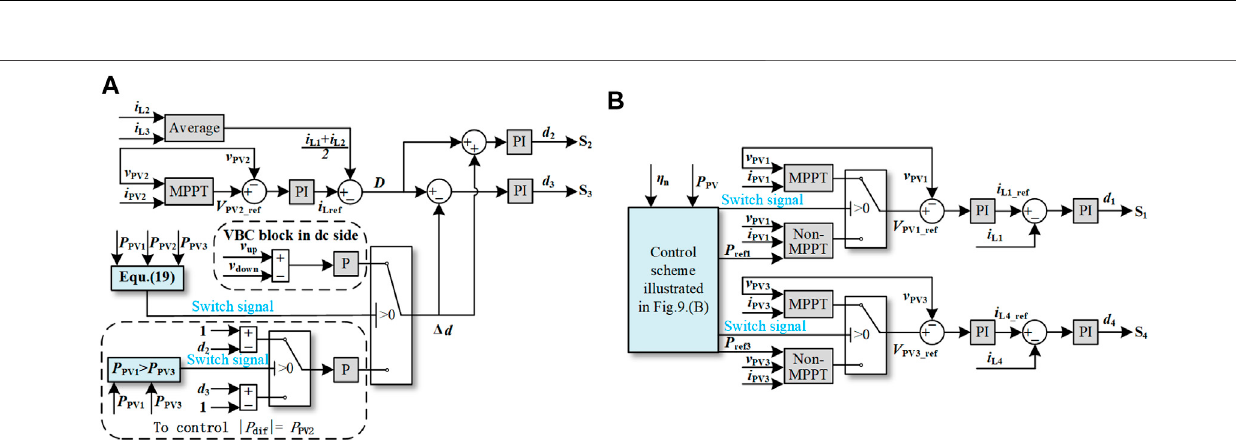
FIGURE 10 | (A) Control scheme of the upper central and lower central converters. (B) Control scheme of the upper and lower